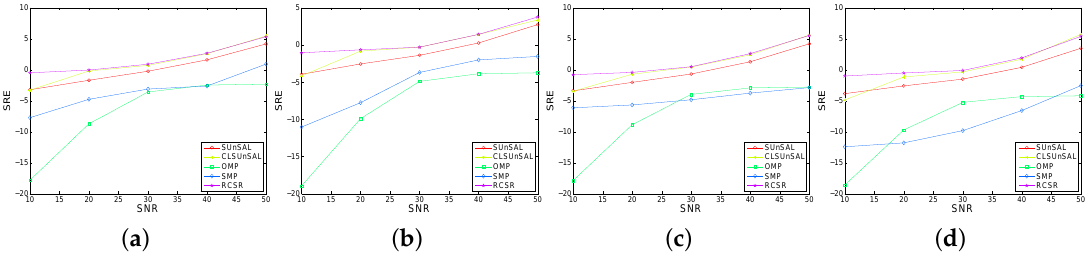
Figure 8. Performance of SRE as a function of SNR under correlated noise when the number of endmembers is 20 with the ( a ) LMM; ( b ) FM; ( c ) GBM and ( d ) MGBM.